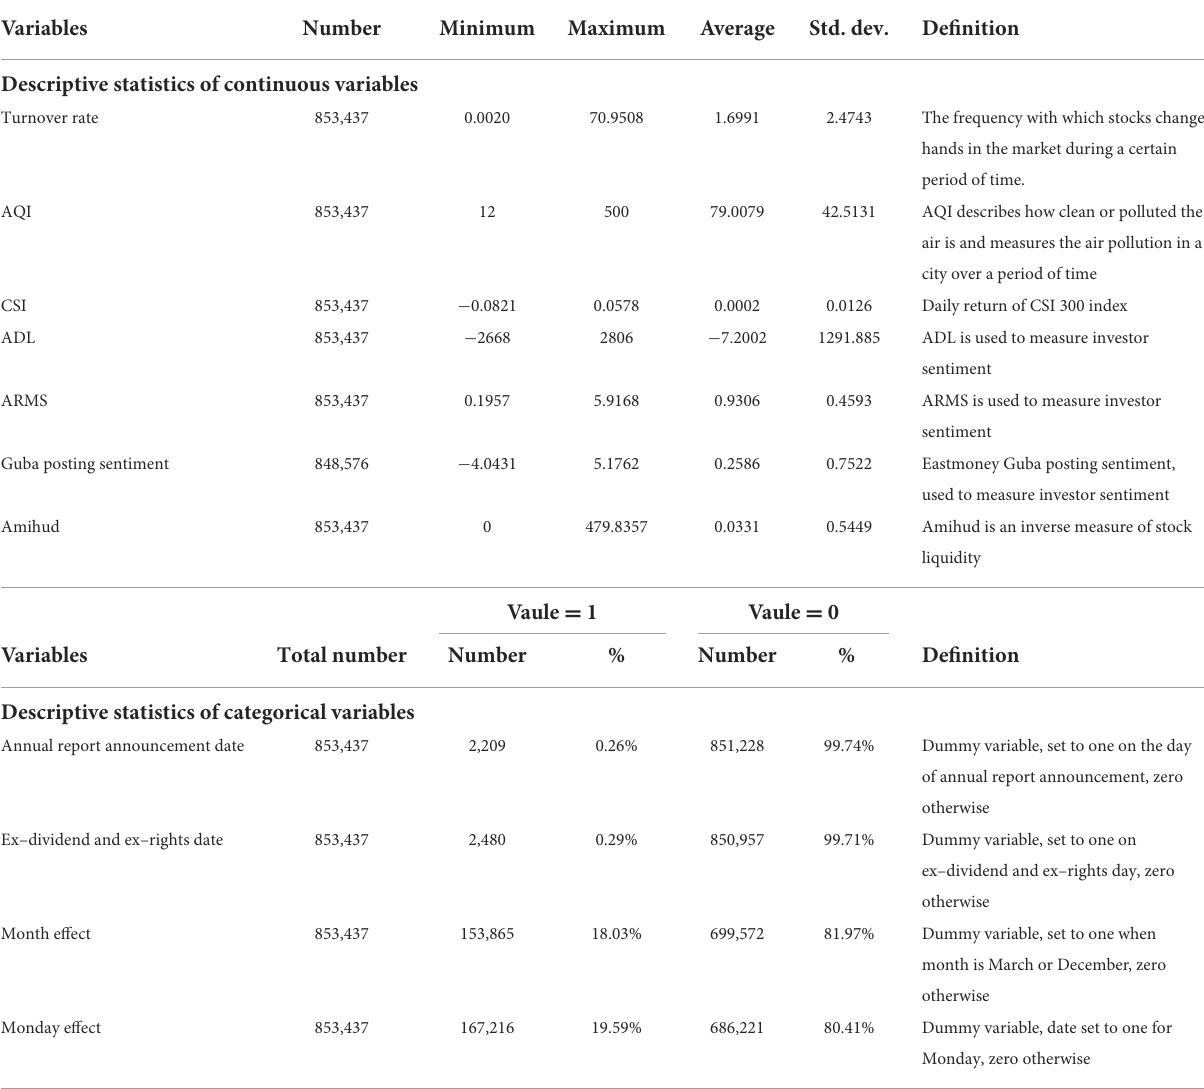
annual fixed effect, urban fixed effect and individual fixed effect. Column (2) includes all control variables, but includes annual fixed effect and individual fixed effect, and does not control urban fixed effect. Column (3) adds all control variables, but adds urban fixed effect and individual fixed effect, and does not control annual fixed effect. Column (4) adds all